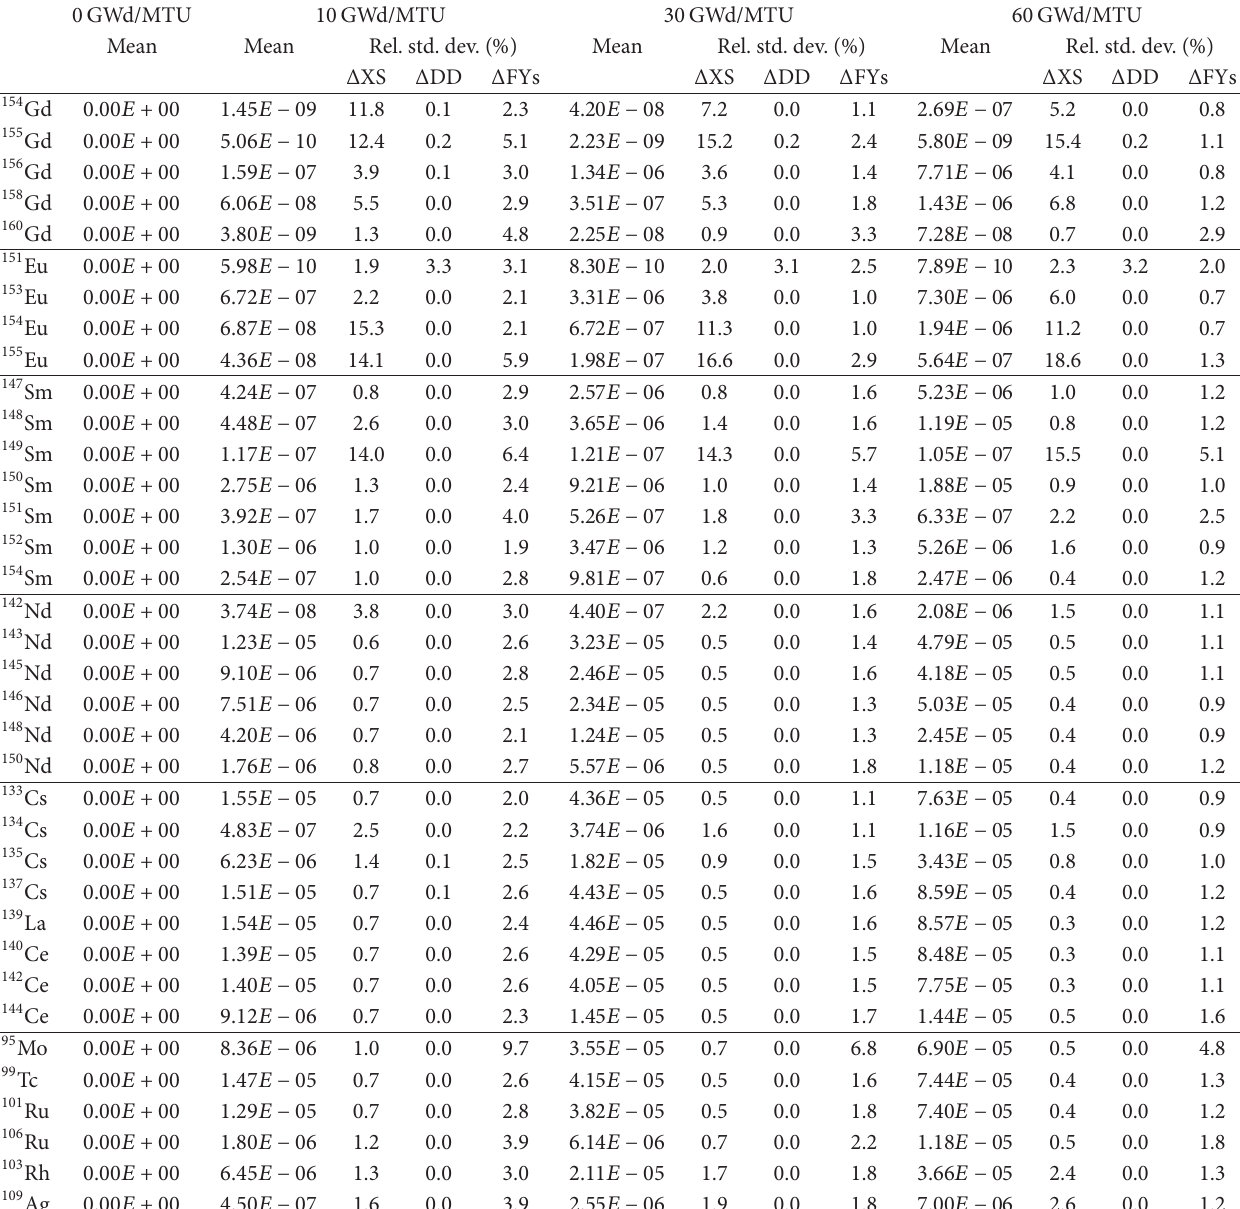
T 10: Uncertainty in number density of some important �ssion products. Cross-section uncertainties are ta�en from SCALE6.1/44- GROUP ( XS). Fission yields Δ